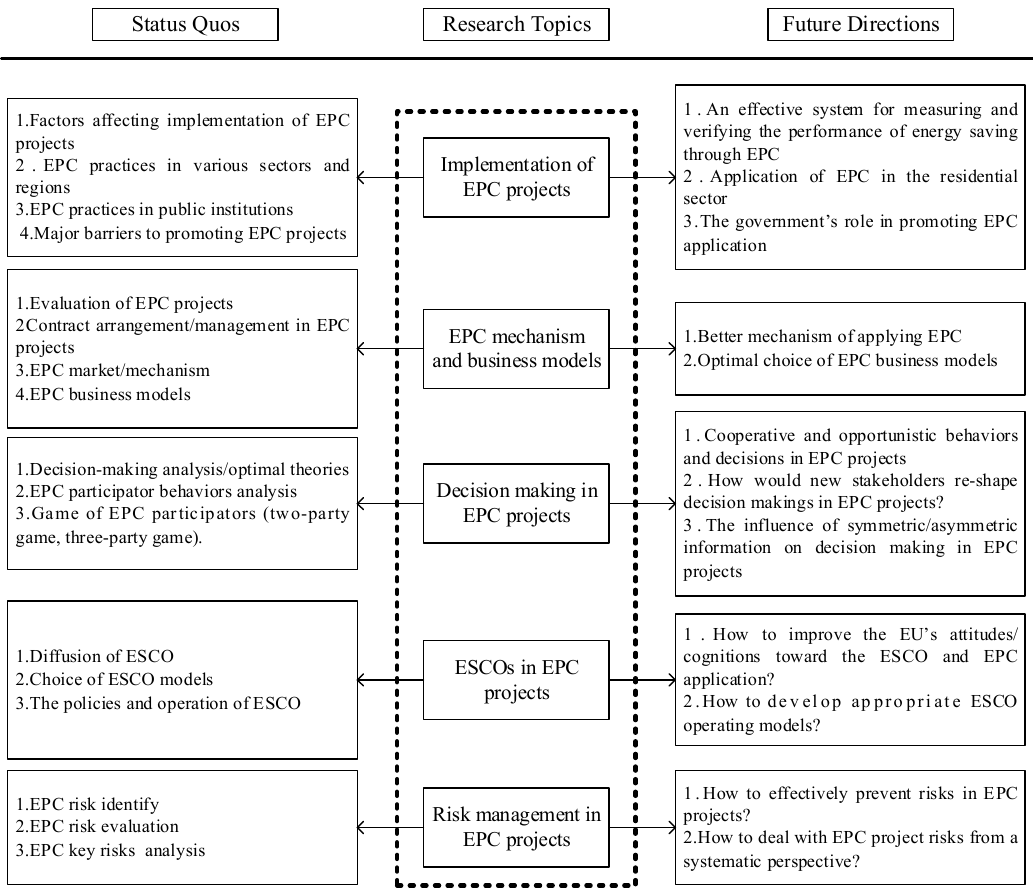
Figure 2. Future research directions/trends in the EPC subject.